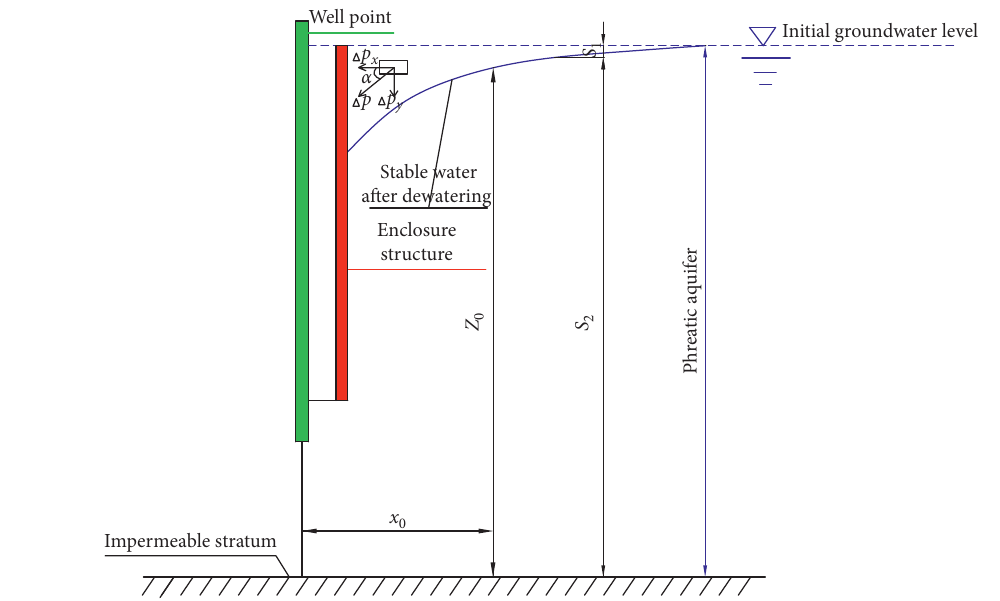
Figure 10: Simplified calculation model considering seepage